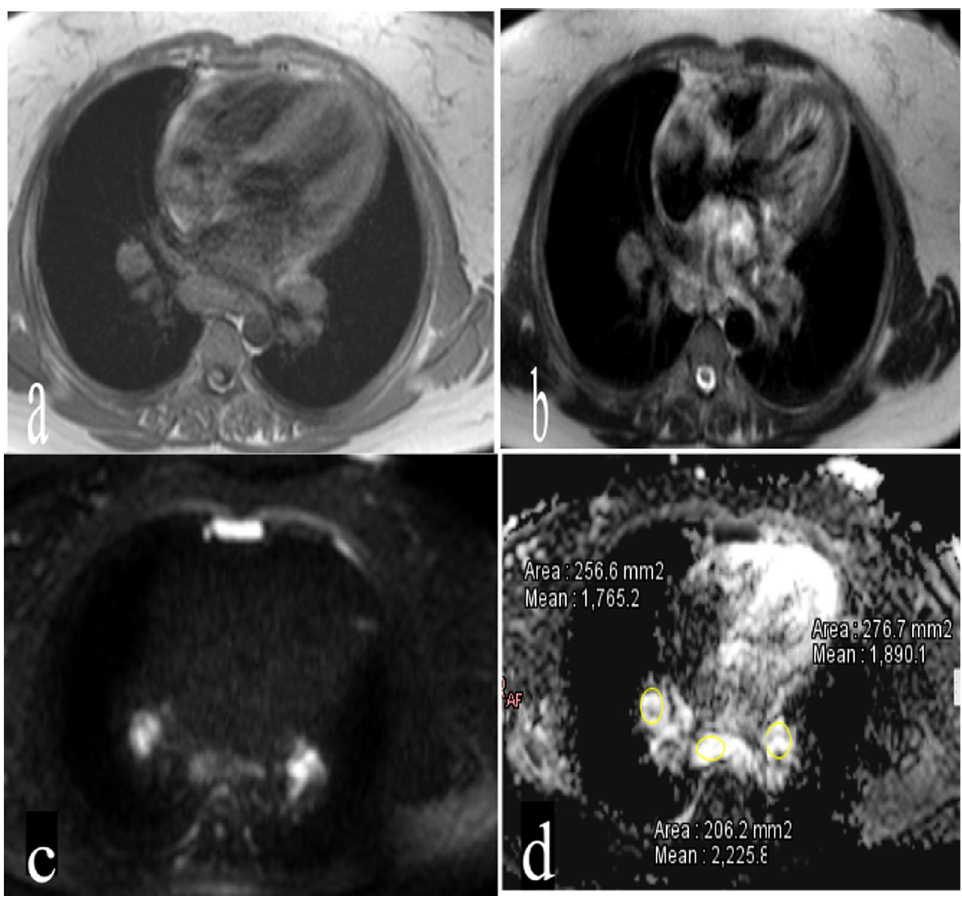
Fig. 3 a Axial T1WI, b axial T2WI, c diffusion-weighted MRI image, d ADC map demonstrating bilateral hilar and subcarinal mediastinal lymph nodes that are isointense on T1, hyperintense on T2 WI, and slightly hyperintense on DWI, with a mean value of ADC equal to